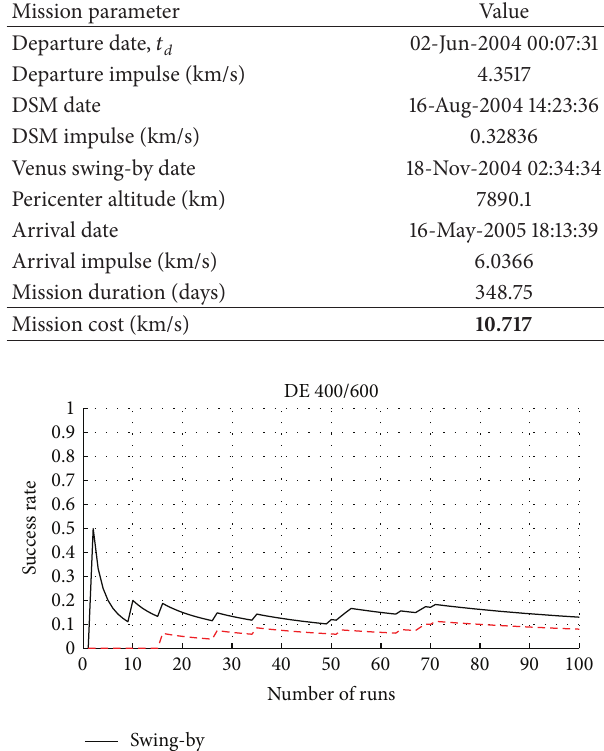
Table 2: Bounds of Earth-Mars mission’s design variables using HGGA.